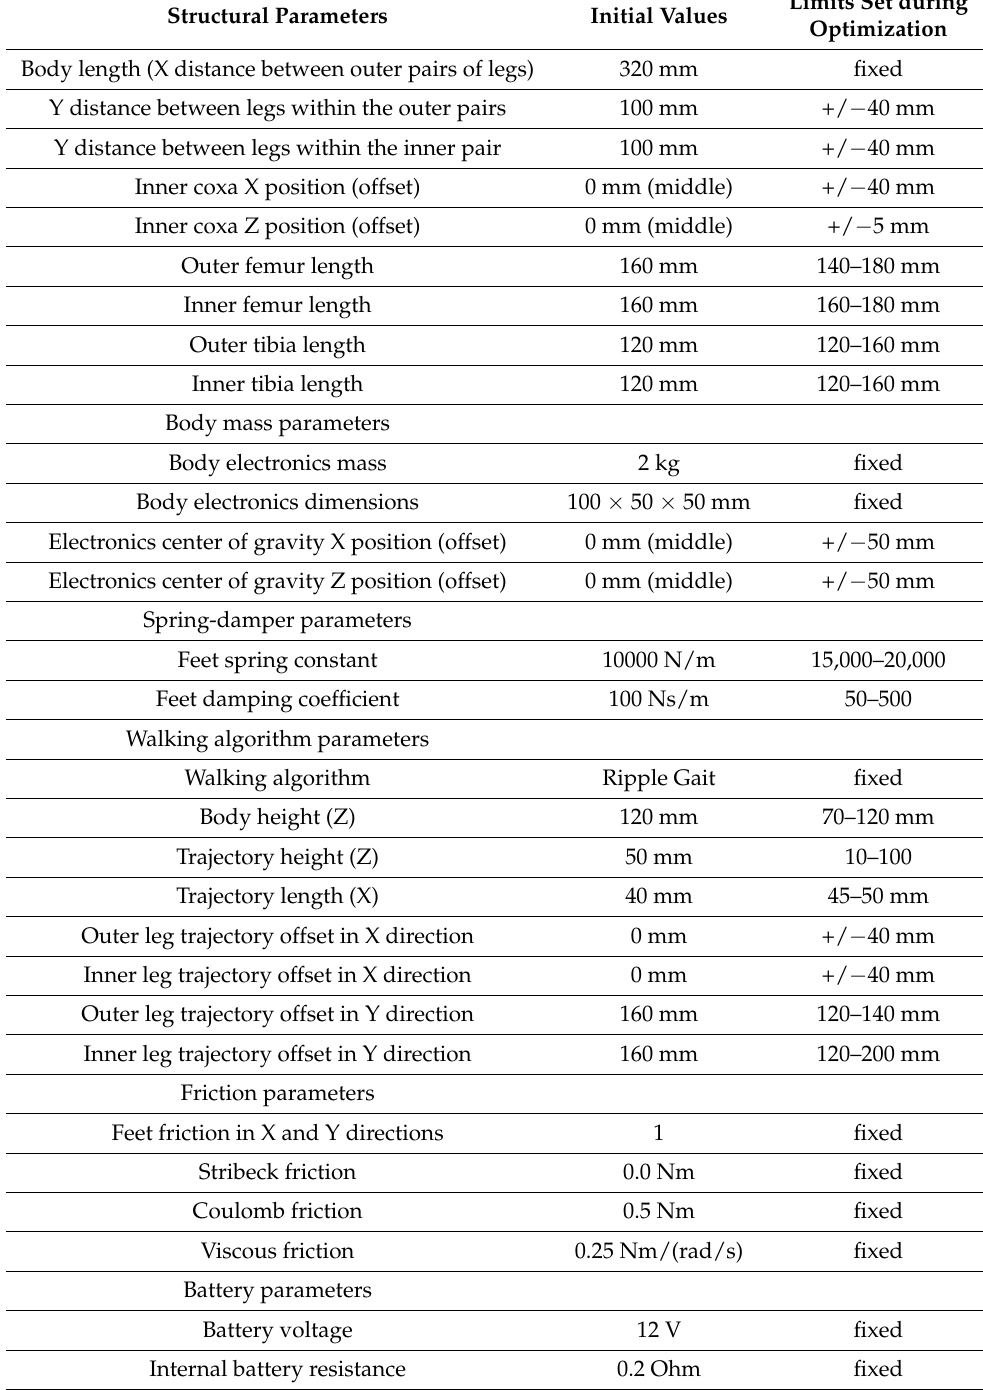
Table 2. Variable and fixed parameters of the